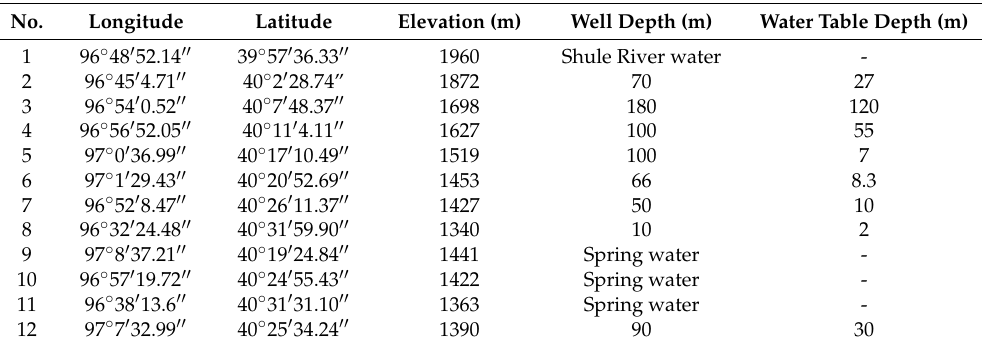
Table 1. Location and general characteristics of sampling